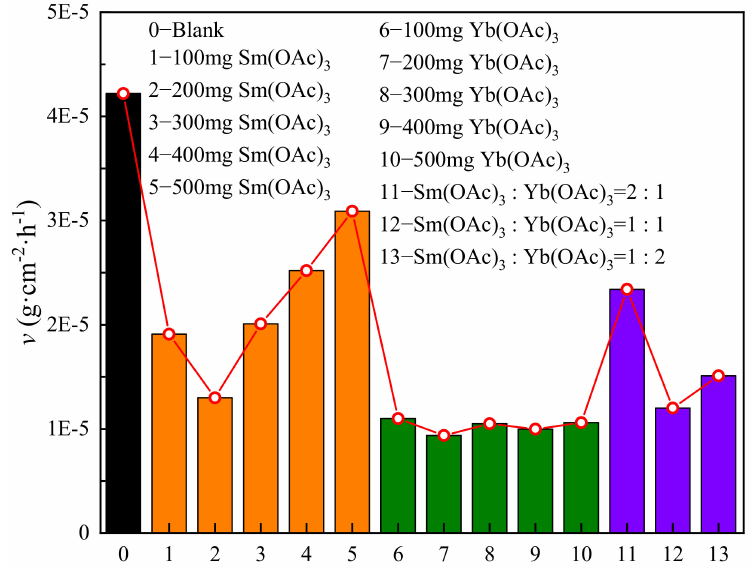
Figure 1. Self-corrosion rate of 7075 samples immersed in 3.5 wt.% NaCl with different additives for 8 days.